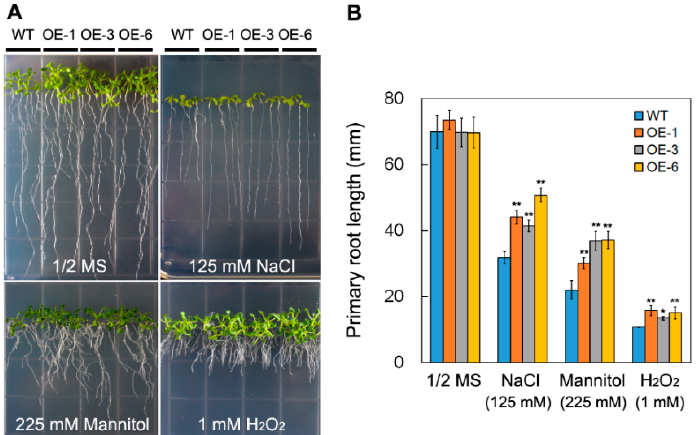
Figure 7. Phenotypes of wild type (WT) and DsSWEET17 transgenic Arabidopsis seedlings under various stresses. Seedling growth ( A ); and root length ( B ) of WT and three transgenic lines on 1/2 Murashige and Skoog’s (MS) medium or 1/2 MS medium supplemented with NaCl (125 mM), mannitol (225 mM), and H 2 O 2 (1 mM). Asterisks indicate significant differences between WT and transgenic lines (* p < 0.05; ** p < 0.01; Student’s t test). Error bars show the SD of the values from three replicates.